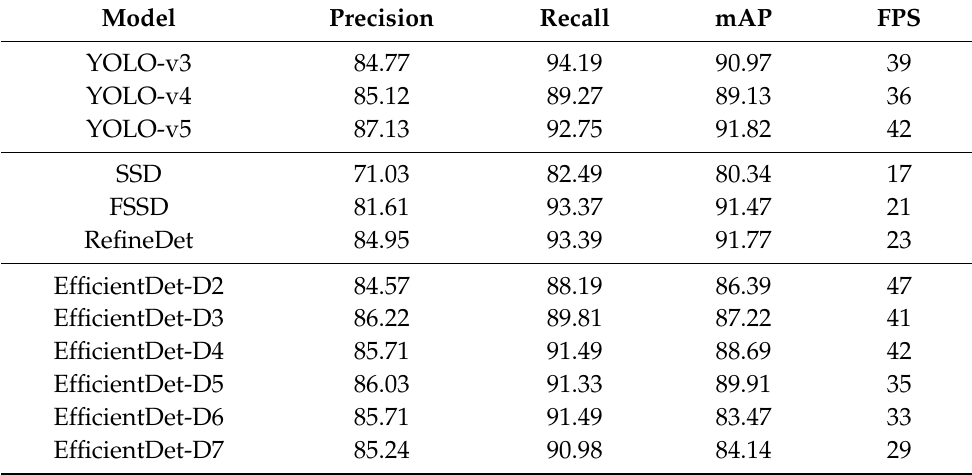
Figure 12. Training curves of accuracy and loss against number of iterations on EfficientDet series, part II. Table 3. Comparisons of different detection network series’ performance (in